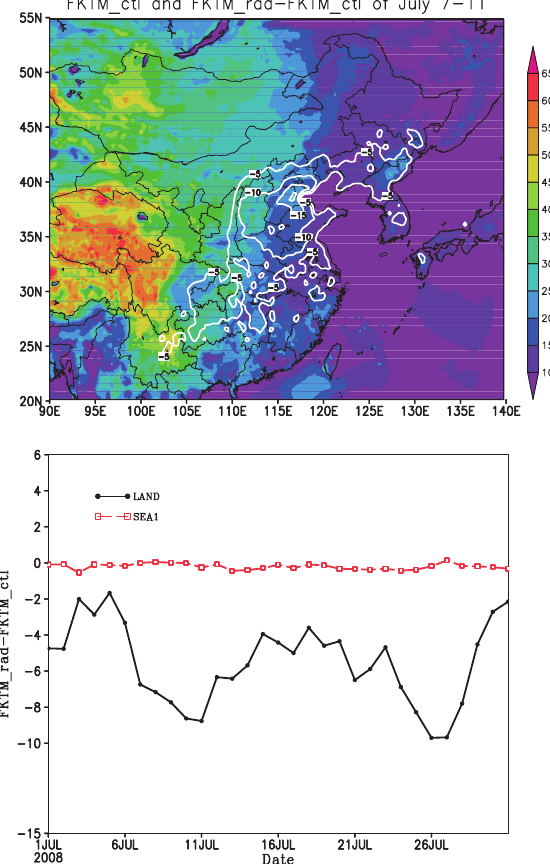
Figure 5. PBLH changes (m) due to aerosol DRF: (a) daytime mean PBLH of the CTL experiment (contour) and its difference between the RAD and CTL experiments (shading) during 7–11 July; (b) LAND- and SEA1-averaged PBLH difference between the RAD and CTL experiments from 1 to 31 July